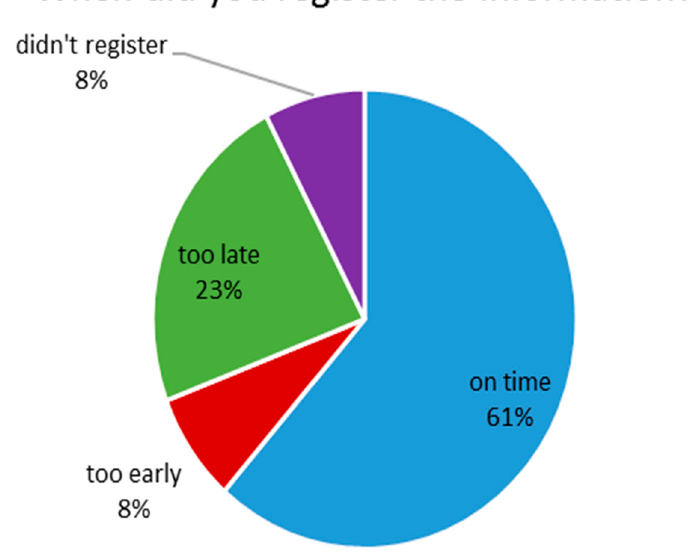
Figure 7. Information registration.